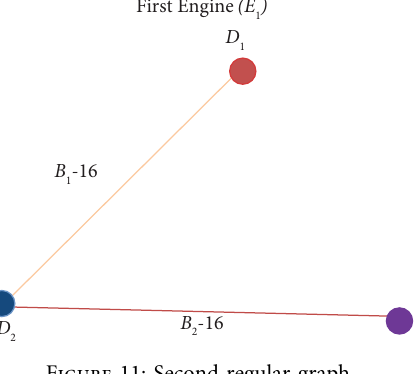
Figure 10: First regular graph.